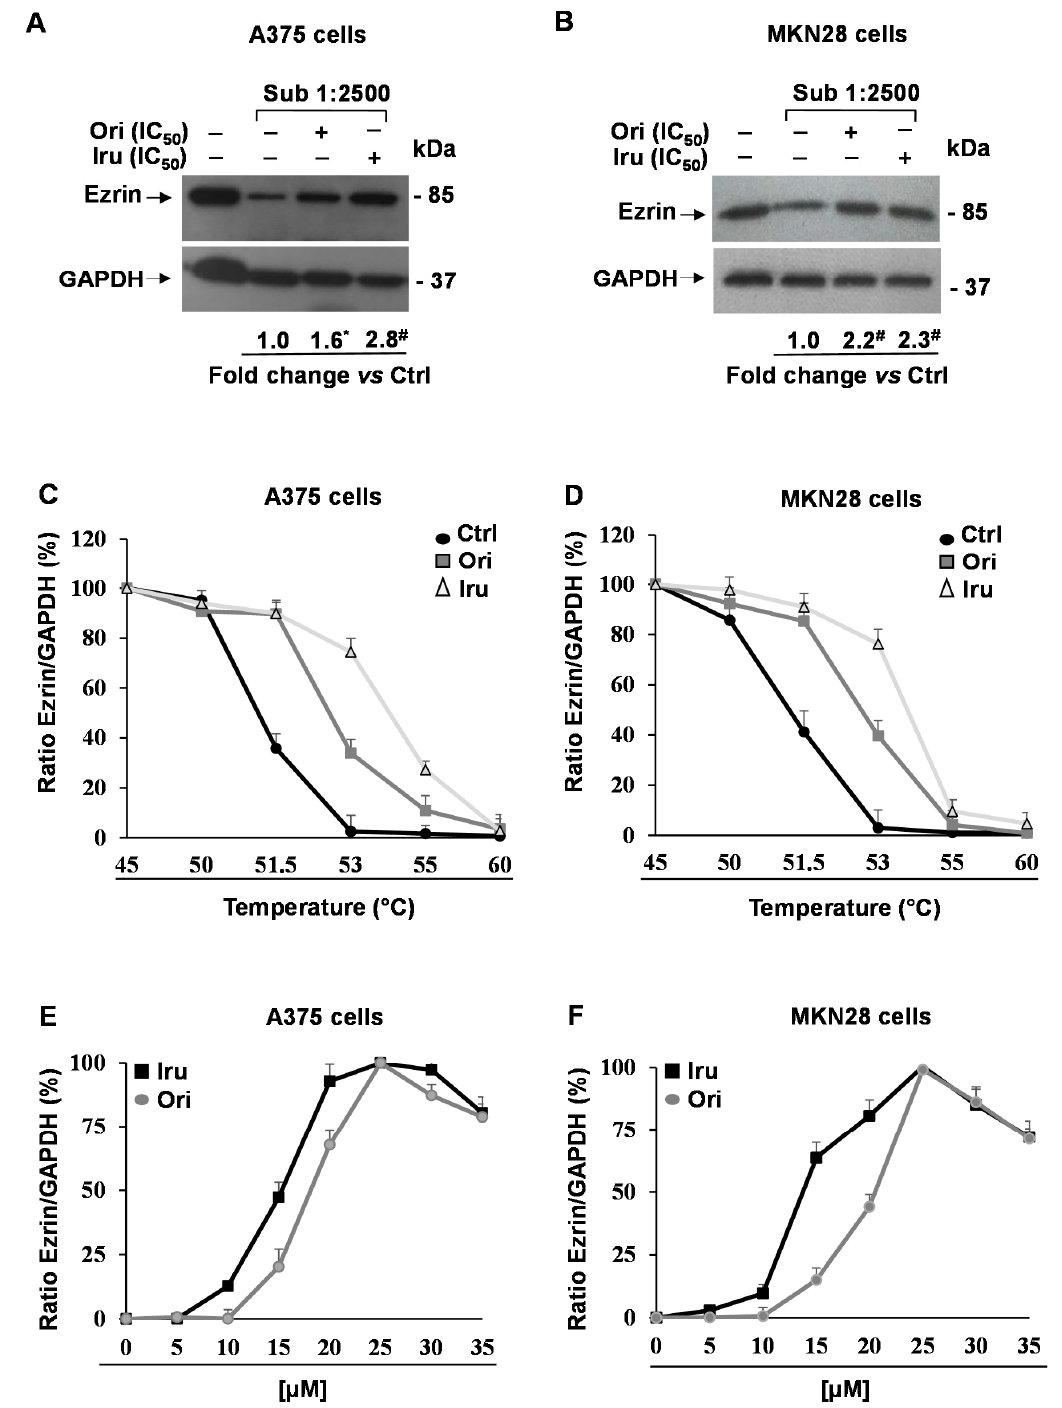
Figure 4. Identification of Ori and Iru protein targets in A375 and MKN28 cell. Western blotting showing Ezrin protein levels in ( A ) A375 and ( B ) MKN28 cells treated with IC 50 values of Ori or Iru for 2 h. After treatments, cells were subjected to a limited digestion with subtilisin and partially hydrolyzed protein mixtures were used for Western blotting analysis of DARTS experiments. GAPDH was used as a control protein as it partially resists to subtilisin-catalyzed proteolysis. Fold change in Ezrin levels was calculated by first normalizing to GAPDH levels in individual samples and then relative to un-treated control set as 1. (*, #) indicate statistical significance toward control (* p < 0.05; # p < 0.001). Statistical analysis of the results obtained in triplicate experiments are reported